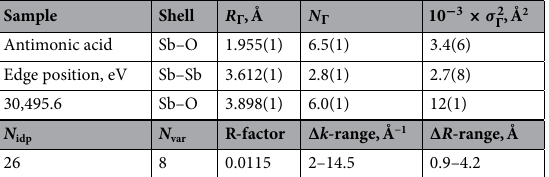
Table 4. Structural parameters extracted from EXAFS data. R Ŵ is the distance from absorber atom, N Ŵ is the average coordination number, σ 2 Ŵ the Debye–Waller factor, and R -factor stands for the quality factor of the fitting. Maximum number of independent variables as imposed by the uncertainty principle: N idp ≈ 2Δ k ΔR/π. N var , number of variables used during the fitting